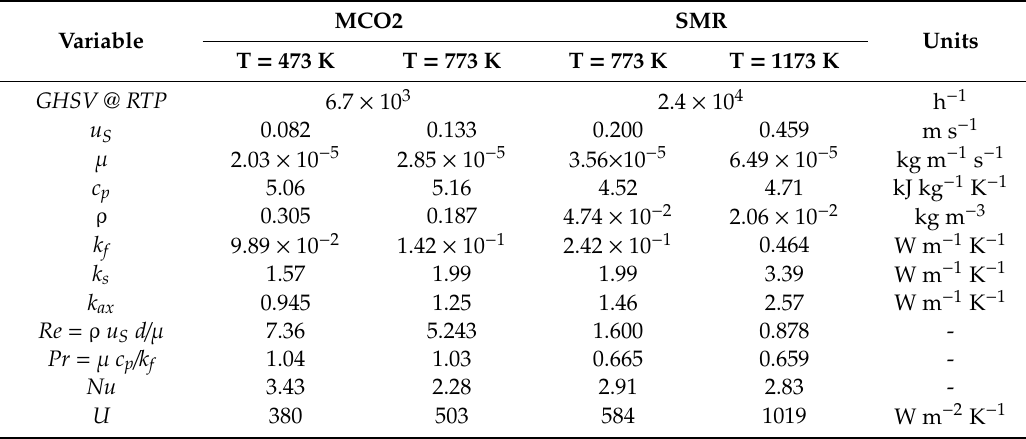
Table 5. Values of the main chemical–physical parameters and dimensionless numbers in the operating conditions adopted in this study. The values reported were evaluated at the reactor